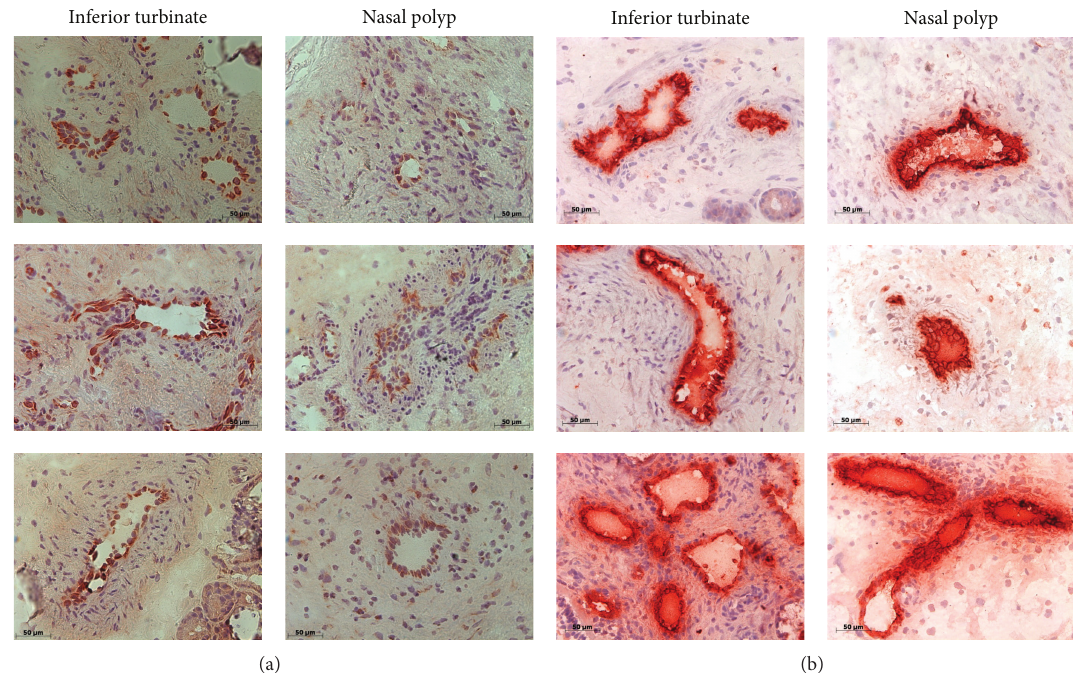
Figure 4: (a): Expression and localization of E-selectin in inferior turbinates and nasal polyps of chronic rhinosinusitis patients ( 𝑛 = 10 ). Immunohistochemical staining was performed on frozen tissue sections of inferior turbinate (left) and nasal polyp (right). We were able to detect E-selectin positive cells in the endothelium of inferior turbinates and nasal polyps. E-selectin was expressed at high level in the inferior turbinates, whereas in nasal polyps E-selectin was infrequently expressed and always at a low level. (b) Expression and localization of P-selectin in inferior turbinates and nasal polyps of chronic rhinosinusitis patients ( 𝑛 = 10 ). Immunohistochemical staining was performed on frozen tissue sections of inferior turbinate (left) and nasal polyp (right). P-selectin was detected in the endothelium of inferior turbinates and nasal polyps. P-selectin was always expressed at high levels in both inferior turbinates and nasal polyps.